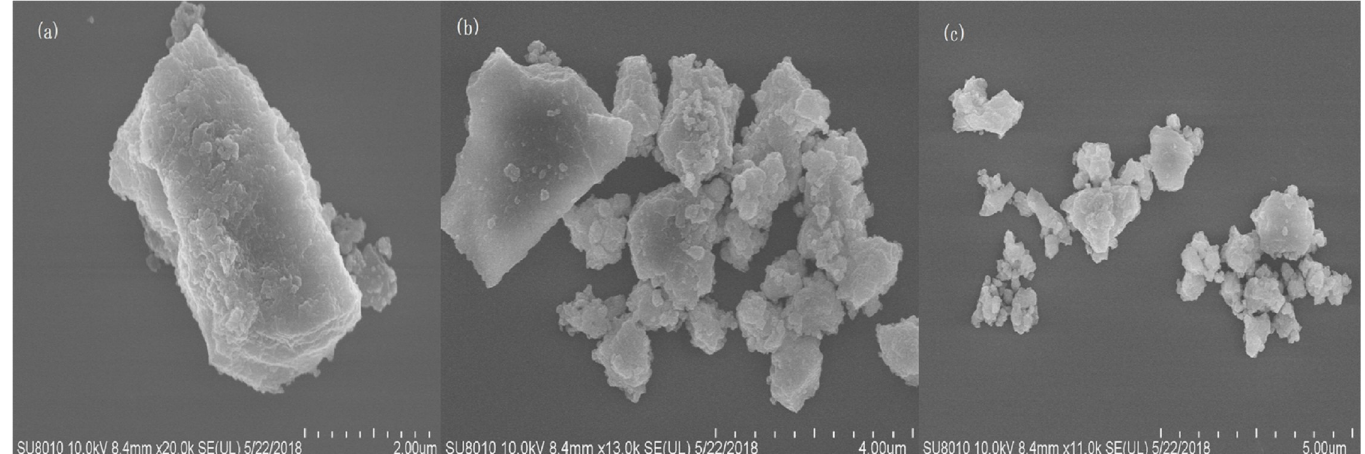
Fig 2. SEM image of Yichang phosphorite samples: (a) inactivated, marker 2 μ m; (b) 30 min activated, marker 4 μ m; (c) 60 min activated, marker 5 μ m.